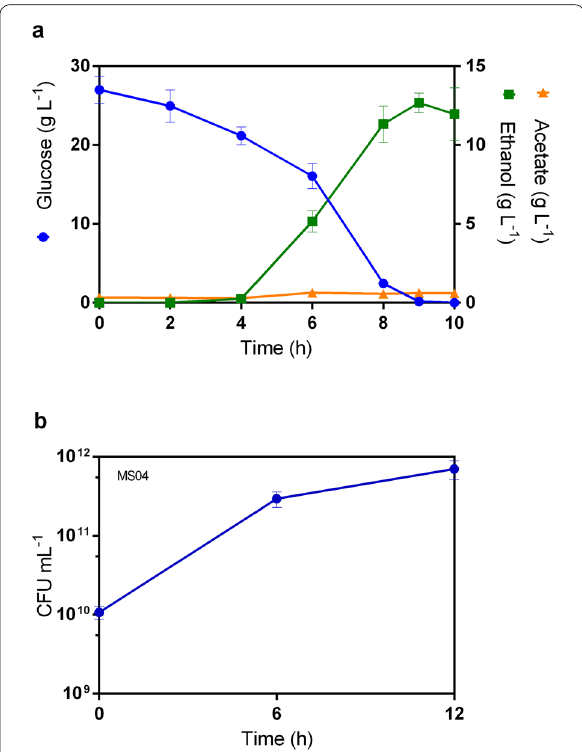
Fig. 3 a Fermentation kinetics of glucose consumption, ethanol production and acetate production. b E. coli growth expressed as Colony‑Forming Units (CFU mL − 1 ) during the fermentation process